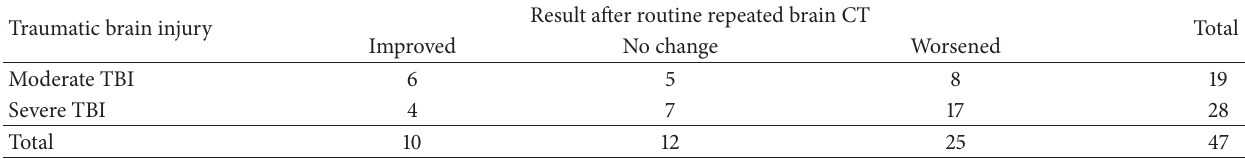
Table 6: Comparison of the result of routine repeated brain CT versus initial brain CT in moderate and severe TBI